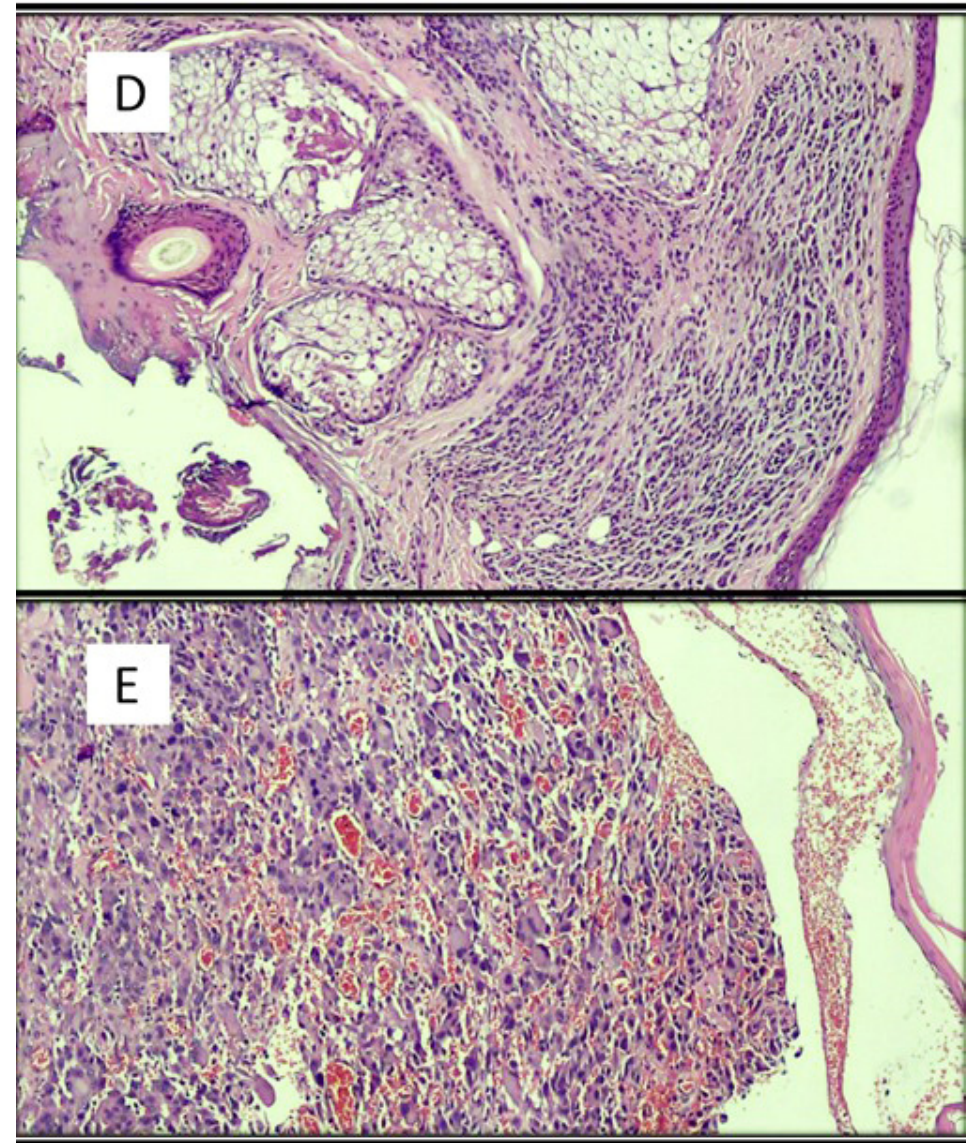
Figure 2. Examples of images of lesions used in various studies in the literature. ( A ) Basal cell carcinoma, superficial variant (hematoxylin–eosin, original magnification: 4×). ( B ) Seborrheic keratosis, hyperkeratotic variant (hematoxylin–eosin, original magnification: 10×). ( C ) Squamous cell carcinoma (hematoxylin–eosin, original magnification: 20×). ( D ) Intradermic nevus (hematoxylin–eosin, original magnification: 10×). ( E ) Amelanotic malignant melanoma (hematoxylin–eosin, original magnification: 20×).